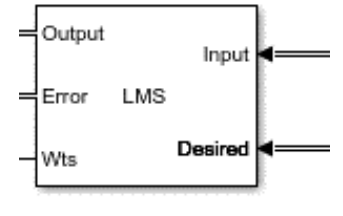
Figure 8. LMS Filter Block used in the model